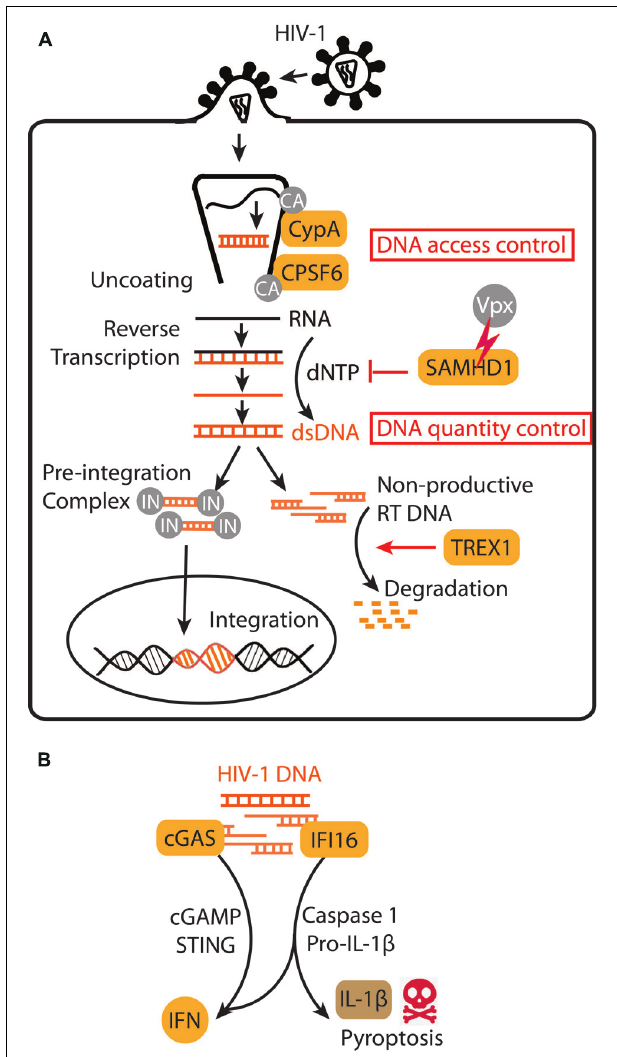
FIGURE 1 | HIV-1 subversion of innate immune DNA sensing. (A) A schematic diagram of early stages of HIV-1 life cycle. HIV-1 capsid (CA) and associated host factors, CypA and CPSF6, regulate HIV DNA access to innate immune sensing.TREX1 and SAMHD1 regulate HIV DNA quantity. IN, integrase. (B) HIV-1 DNA sensing by cGAS in many target cells activates a STING-mediated IFN response, whereas HIV-1 DNA sensing by IFI16 in “bystander” quiescent CD4 + T cells trigger IFN signaling, caspase-1 activation, IL-1 β secretion and